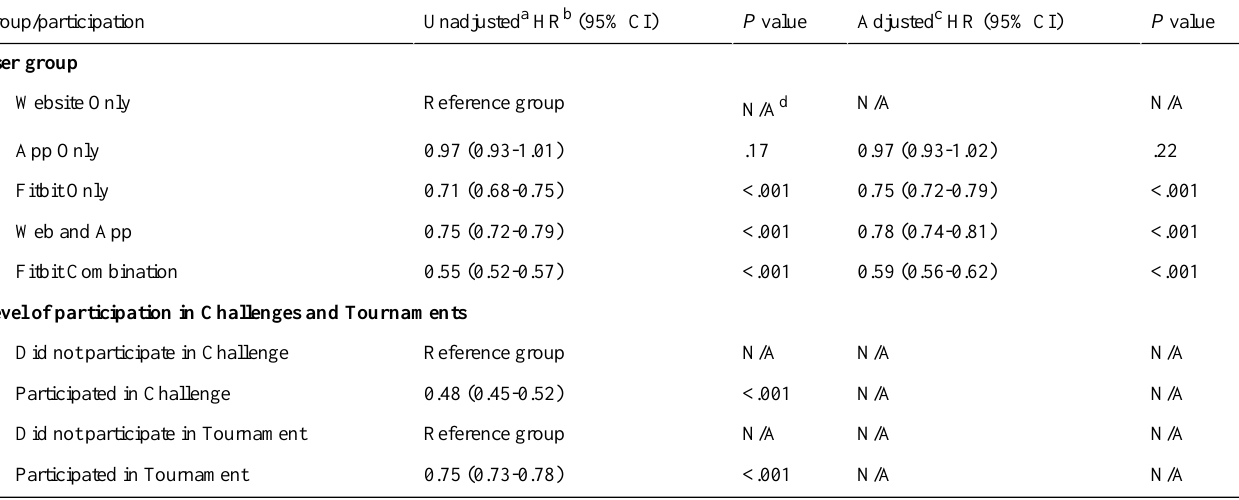
Table 4. Cox proportional hazard risks for nonusage attrition of 10,000 Steps program, by user group and by participation in Challenges and Tournaments